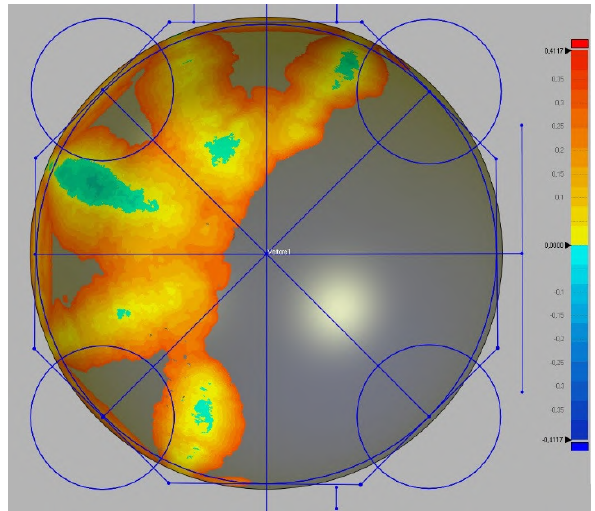
Figure 15. Spherical intrados deviation